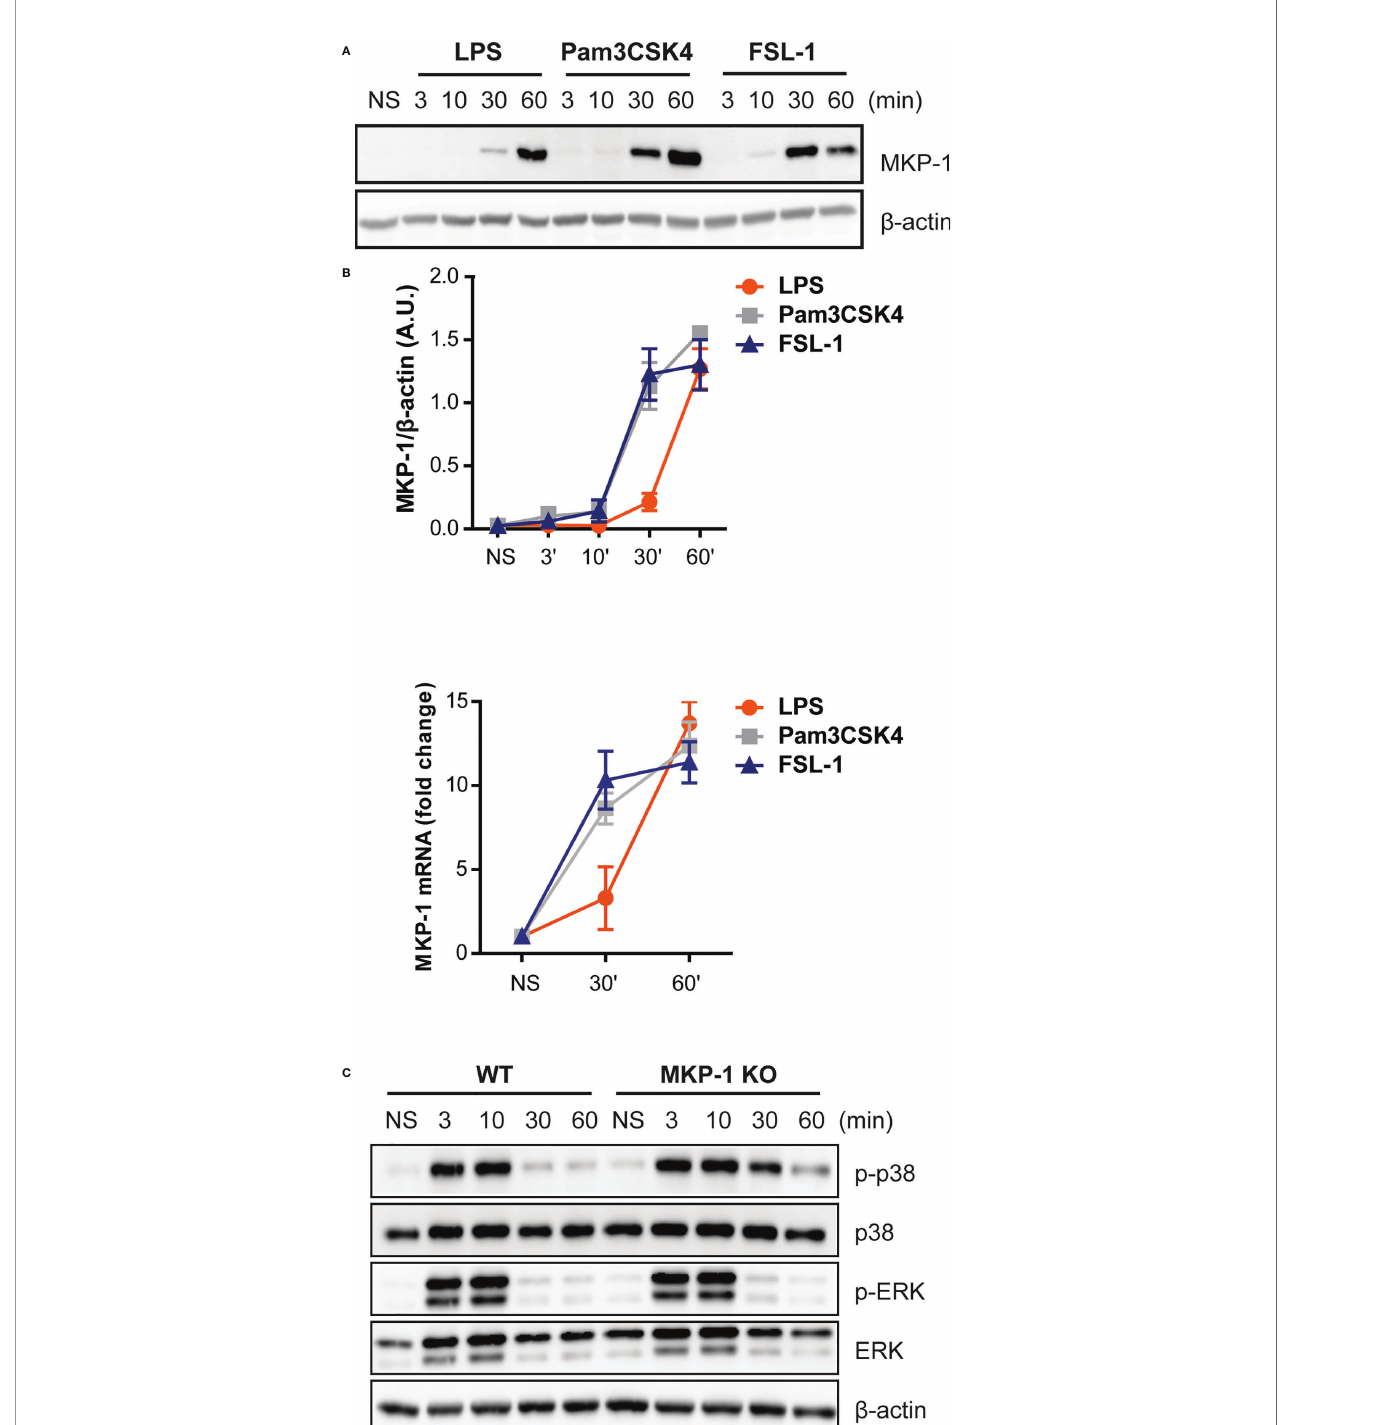
FIGURE 4 | MKP-1 is activated earlier by TLR2 activation and controls TLR2-induced p38 phosphorylation. (A) Raw264.7 cells were left unstimulated (NS) or stimulated with LPS (100 ng/mL), Pam3CSK4 (1 µg/mL) and FSL-1 (100 ng/mL) at 3, 10, 30 and 60 min and protein expression was measured by Western blot. (B) MKP-1 mRNA levels were measured by qPCR after Raw 264.7 cells stimulation with the three ligands at 30 and 60 min. (C) WT and MKP-1 KO peritoneal macrophages were left unstimulated (NS) or stimulated FSL-1 (100 ng/mL) at 3, 10, 30 and 60 min. b -actin was used as protein loading control. Images are representative of two